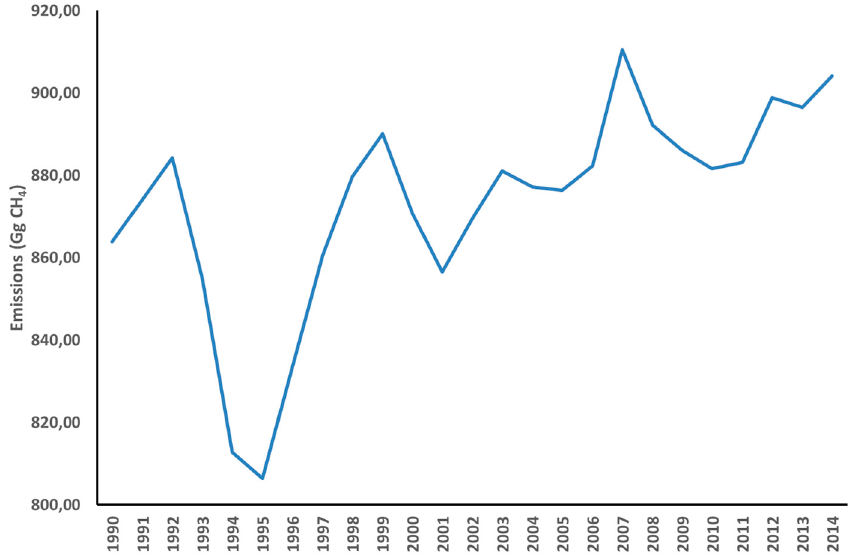
Figure 3. Enteric emissions (Gg CH 4 ) for South African non-dairy cattle from 1990 to 2014.